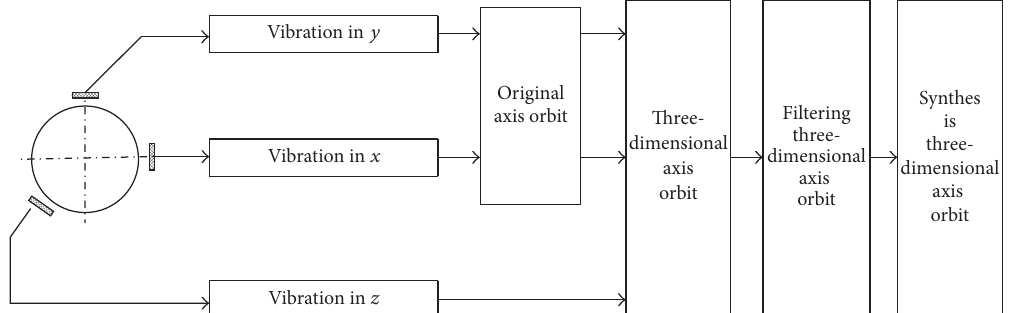
Figure 2: Axis trajectory analysis method in a three-dimensional process.